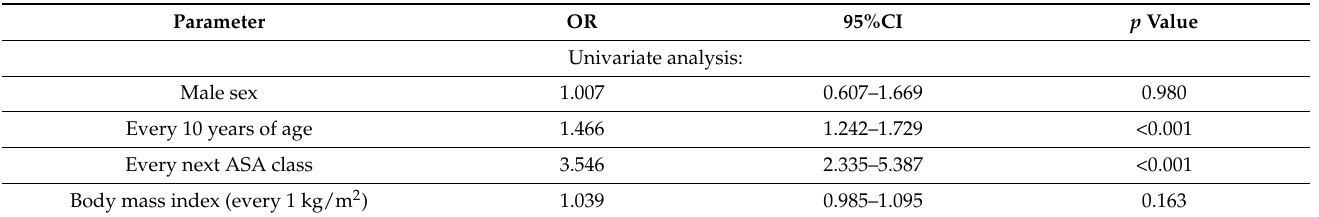
Table 7. Risk factors for major